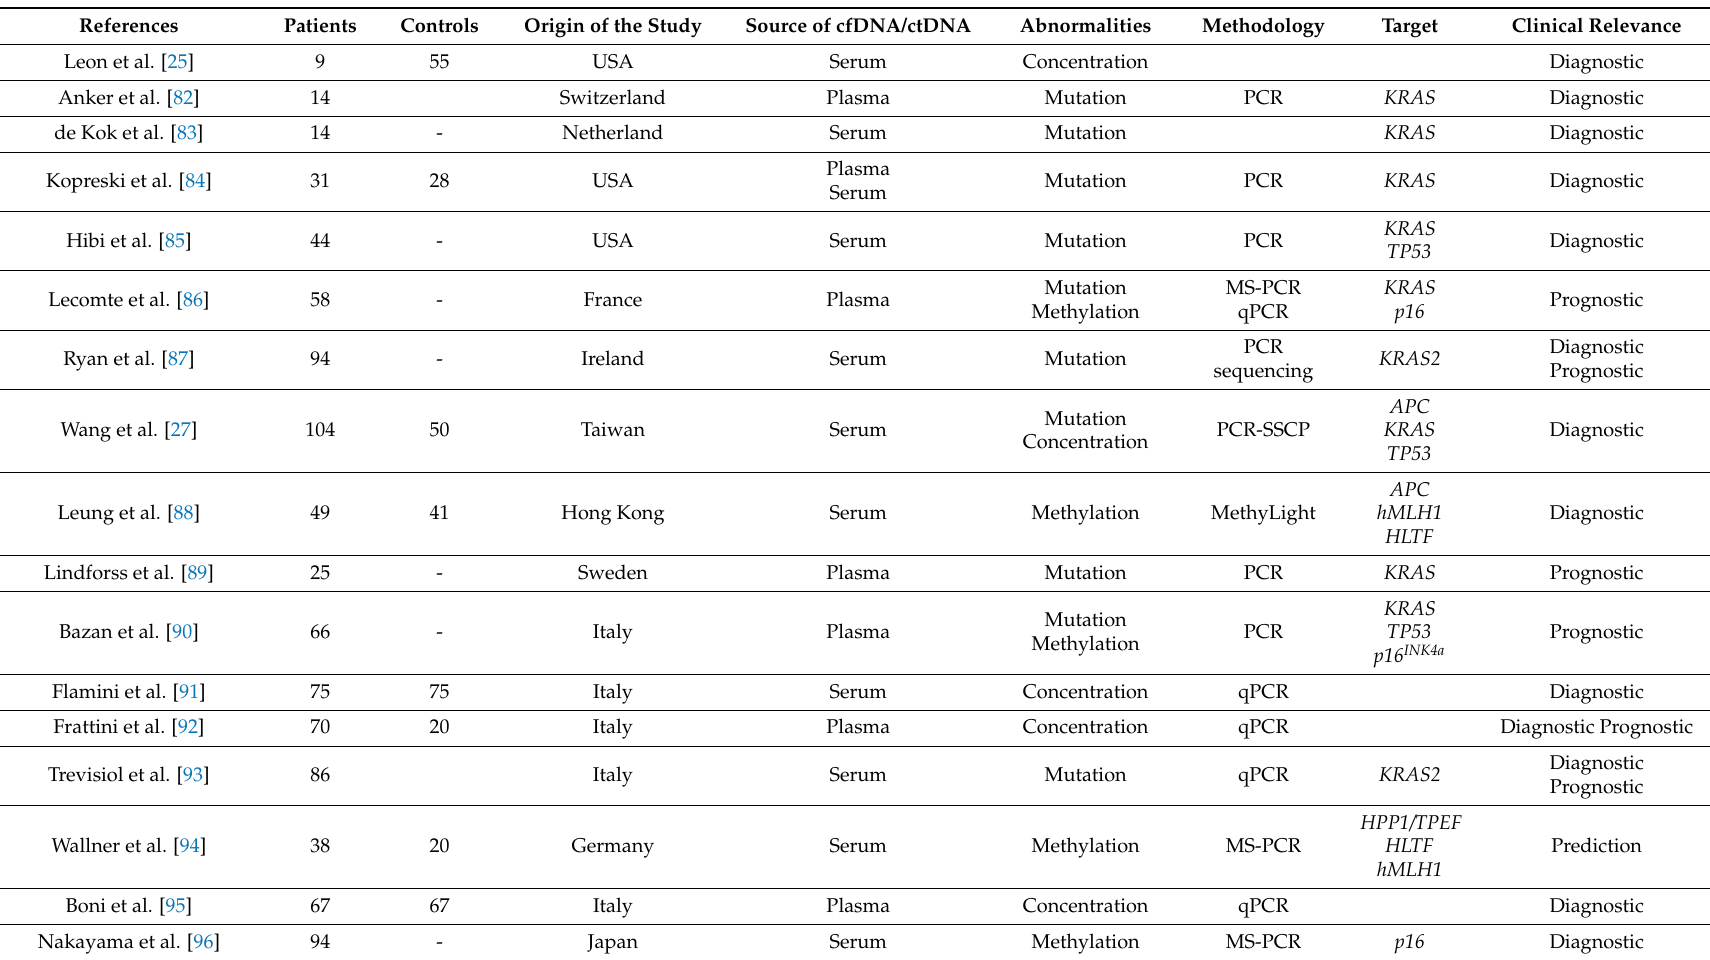
Table 3. An overview of the studies investigating cfDNA/ctDNA in relation to CRC diagnosis, therapy outcome, and